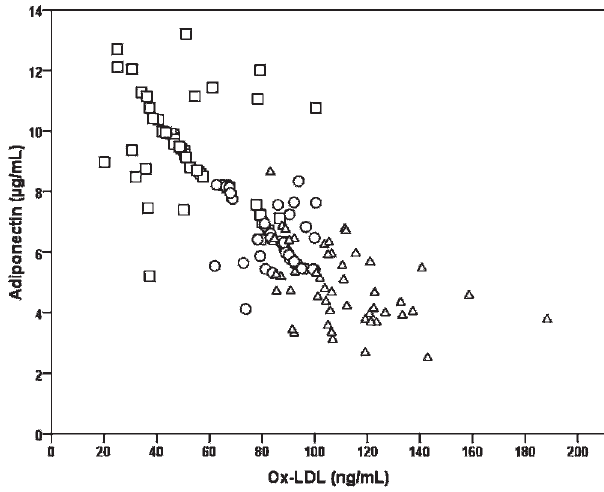
Figure 3 - Correlation between plasma adiponectin and total NO levels in control subjects ( % ), stable angina patients ( # ) and unstable angina patients ( D ).